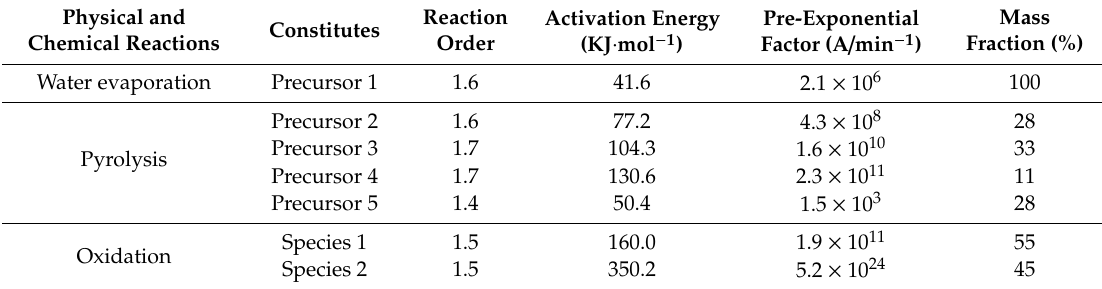
Table 1. Kinetic parameters of the water evaporation, pyrolysis, and oxidation